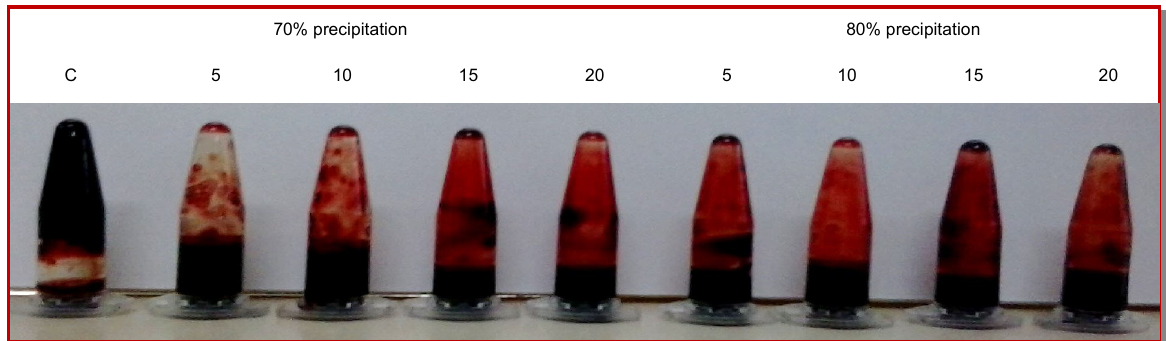
Figure 4: Holmstorm method for Bacillus sp SFN crude supernatant in production media with shrimp shell (10 to 100